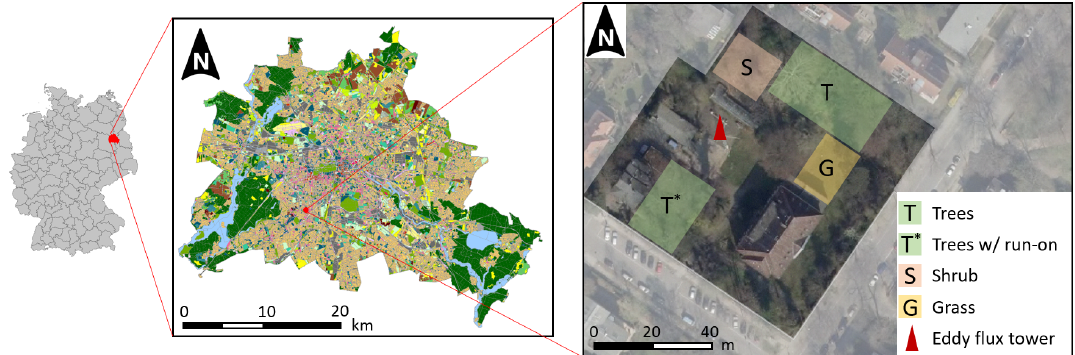
Figure 1. From left: Germany, Berlin and the SUEO with vegetation plots and eddy flux tower. Data source base maps: Senstadt (2015,